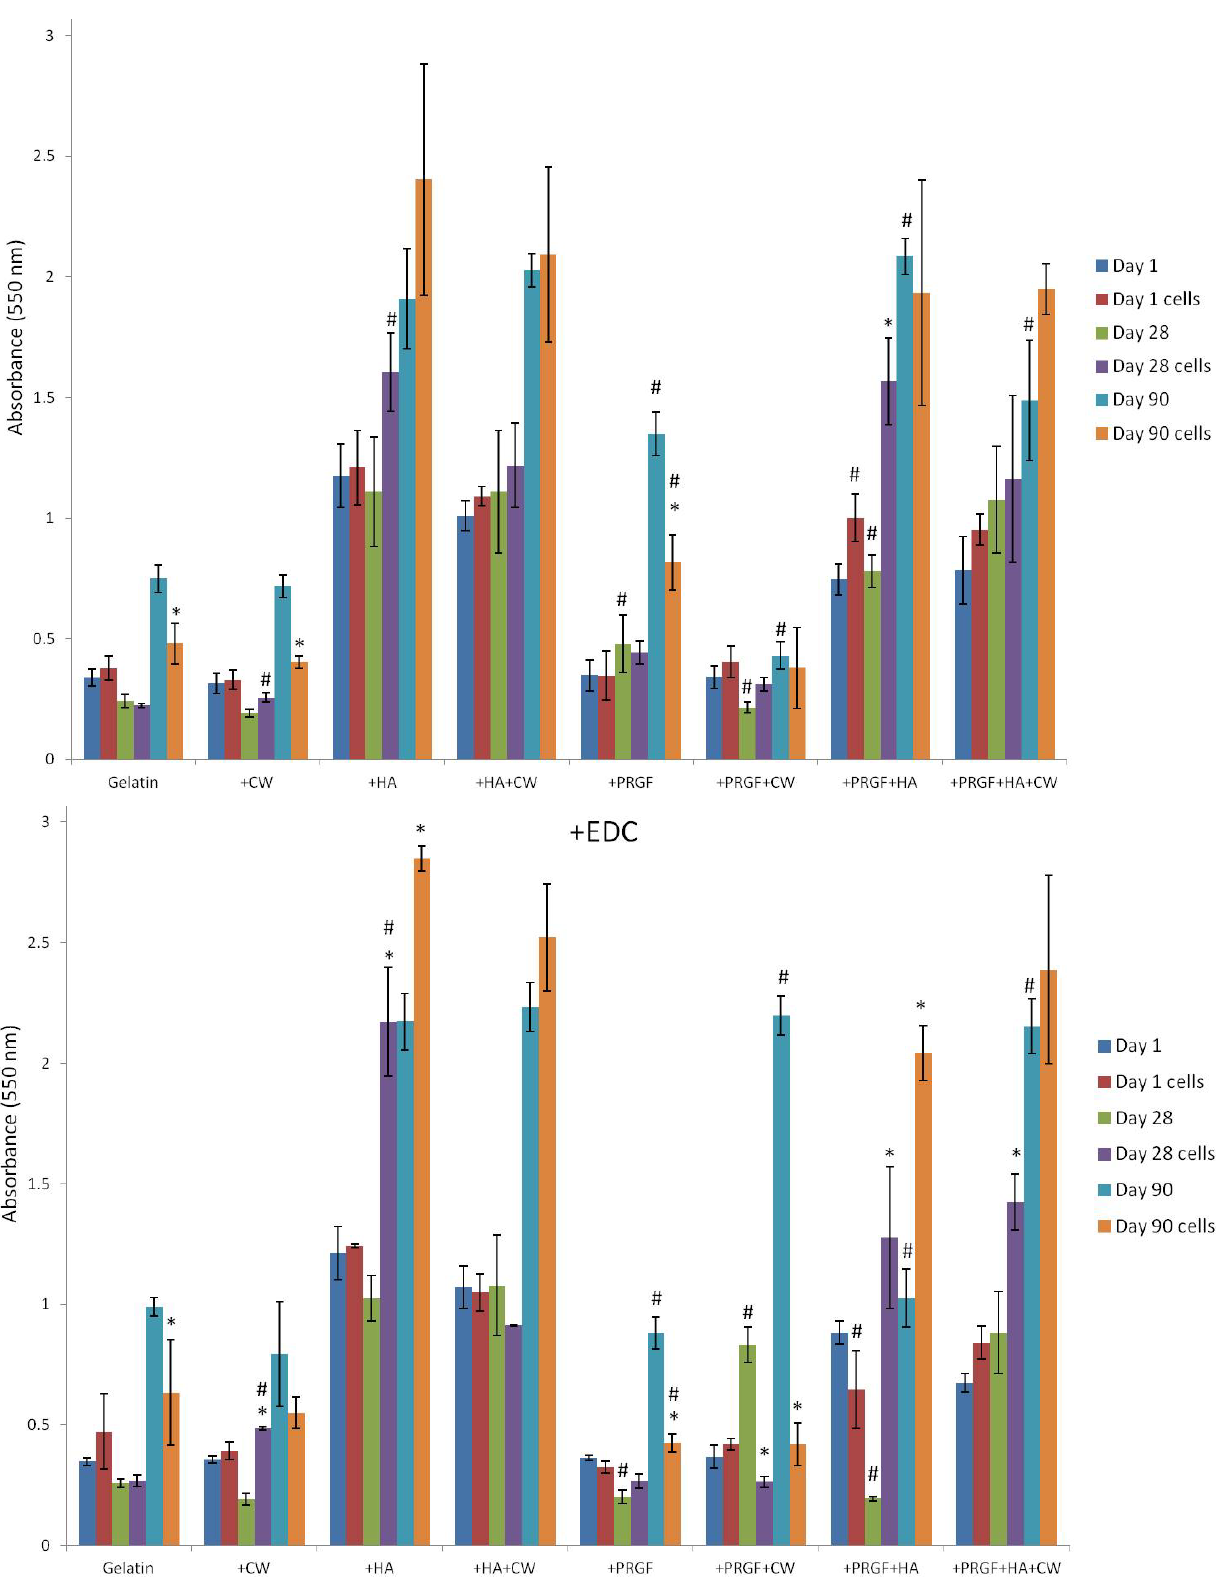
Figure 6. Alizarin Red S staining of acellular and cellular scaffolds over 90 days incubation. * denotes a statistical difference ( p < 0.05) between cells and no cells for a specific day and scaffold composition. # denotes a statistical difference ( p < 0.05) when comparing cross-linking methods of each